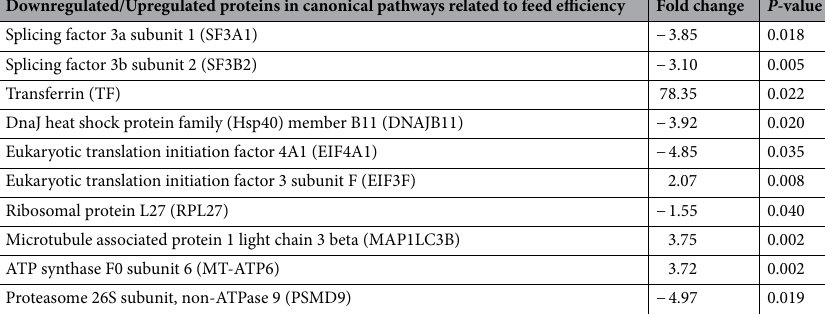
Proteasome 26S subunit, non-ATPase 9 Table 2. Downregulated/Upregulated proteins in canonical pathways related to feed efficiency.